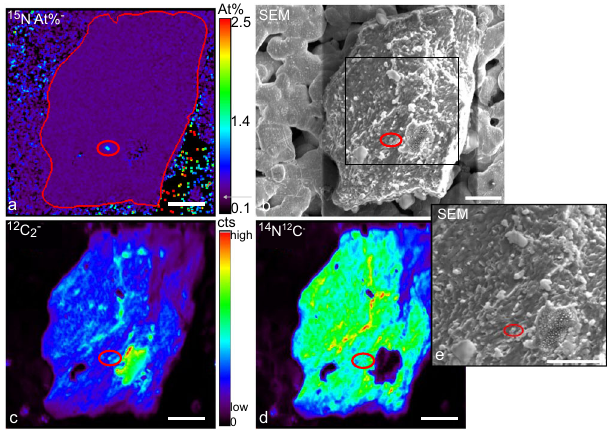
Fig. 2 | Detailed images of one particle with an associated putative NCD (small red circle). a 15 N At% values highlight NCD ROI enriched in 15 N compared to sur- roundingparticle(withinthinredoutline)withenrichmentnearnaturalabundance (purple).Thegreyarrowonthecolorscalebarindicatesnaturalabundanceof 15 NAt %. A total of nine particles from two stations were found with one or more 15 N enriched ROIs. b A scanning electron microscope (SEM) image of the particle and associated cells. One particle with an attached putative NCD was imaged with SEM after nanoSIMS. The black square outlines an area of closer SEM inspection shown in image e . Images c and d show 12 C 2 − and 12 C 14 N − counts (cts) collected during particle analysis with nanoSIMS. Color scale bar is for both c and d , with warmer colors representing higher counts. The cell-like ROI is visible in 12 C 2 − but obscured in d by the high overall values of 12 C 14 N - of the particle. Scale bar is 5 µ